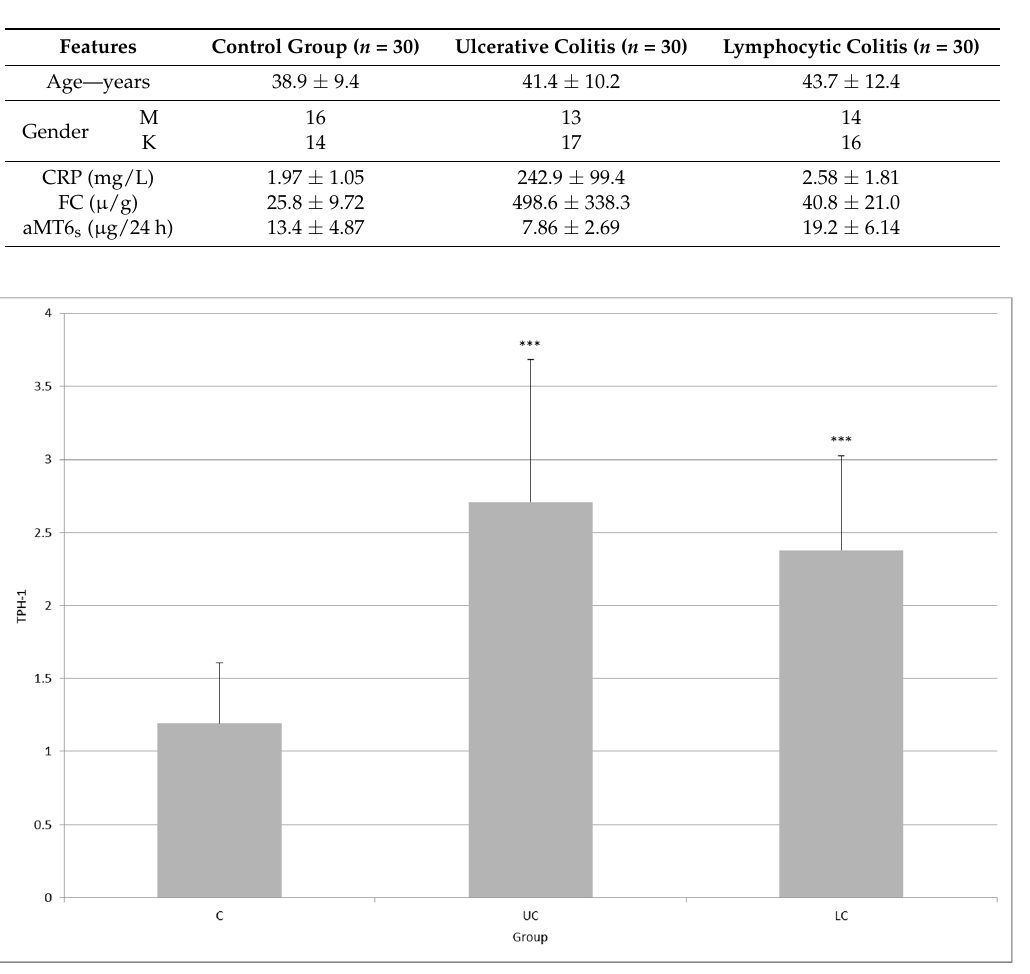
Figure 1. Expression of tryptophan hydroxylase (TPH1) in colonic mucosa in healthy subjects (C) and in patients with ulcerative colitis (UC) and lymphocytic colitis (LC); *** p < 0.001, the difference between UC and LC was not statistically significant ( p = 0.455).